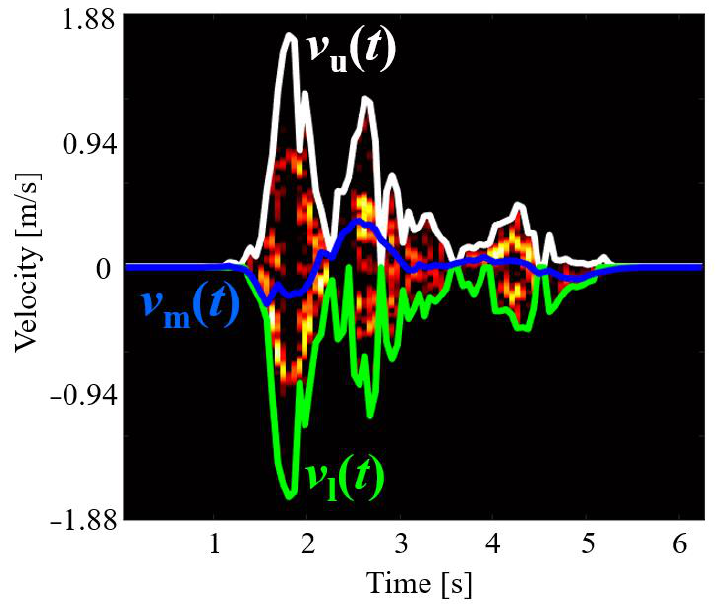
Figure 5. Example of extraction of spectrogram envelopes.